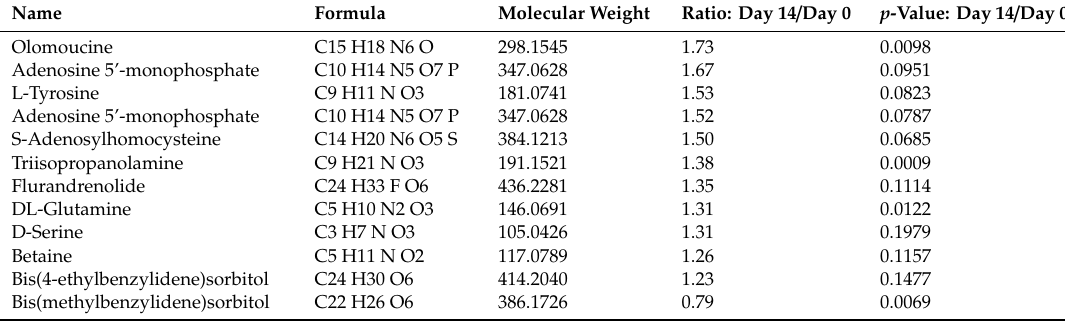
Table 2. Metabolite alterations in colon tissues after a two-week supplementation with walnuts ( n = 10 /